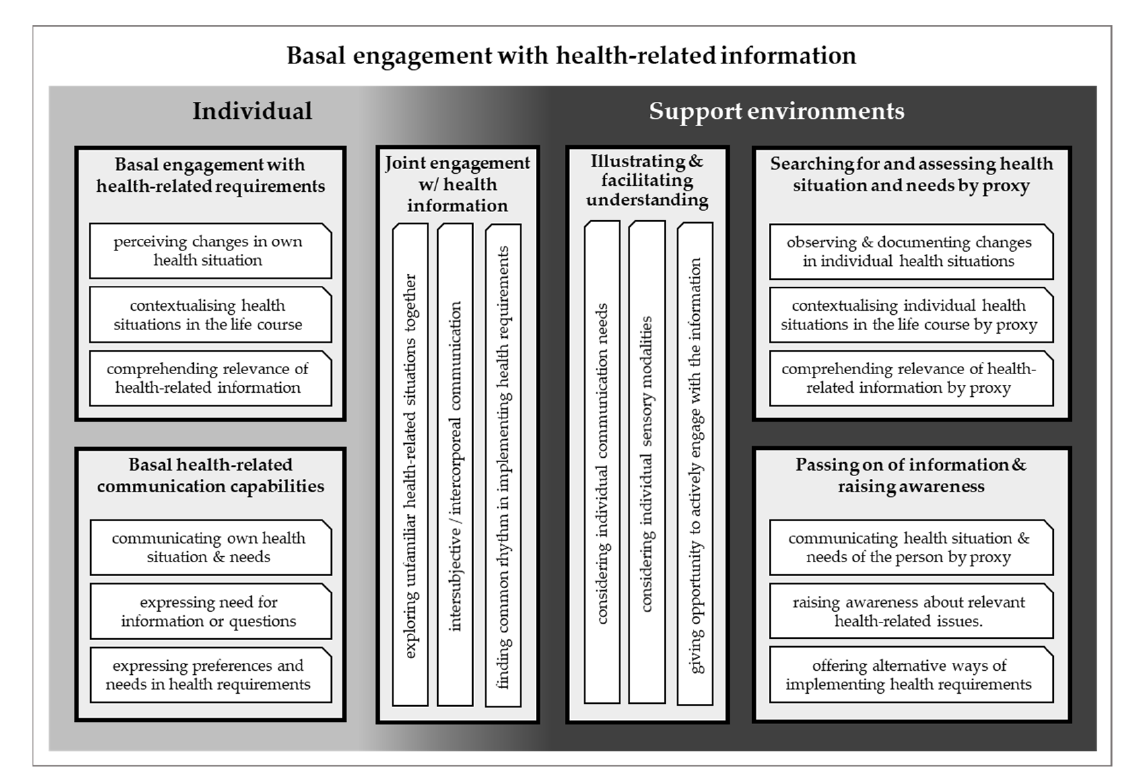
Figure 2. Visualisation of our findings on the basal engagement with health-related information.